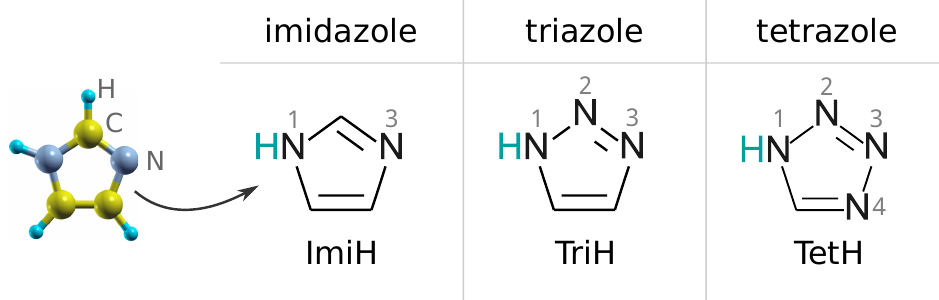
Scheme 1. Skeletal formulas of imidazole, triazole, and tetrazole. Numbering of N atoms is also indicated. ImiH, TriH, and TetH are shorthand labels for the intact imidazole, triazole, and tetrazole, respectively. Note that dissociative adsorption involves the cleavage of the N1–H bond, i.e., the cyan colored H is stripped off the molecule. Atom coloring as used in this work is indicated on the ball-and-stick model of imidazole shown on the